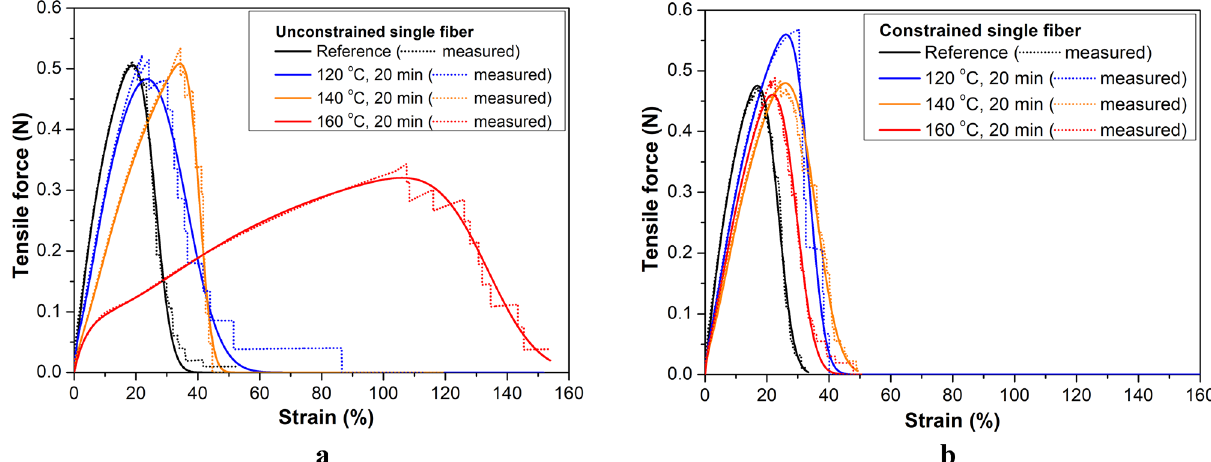
Figure 11. Measured and fitted E-bundle force–strain curves of fibers unconstrained ( a ) and constrained ( b ). Heat treatment was performed at different temperatures for 20 min.